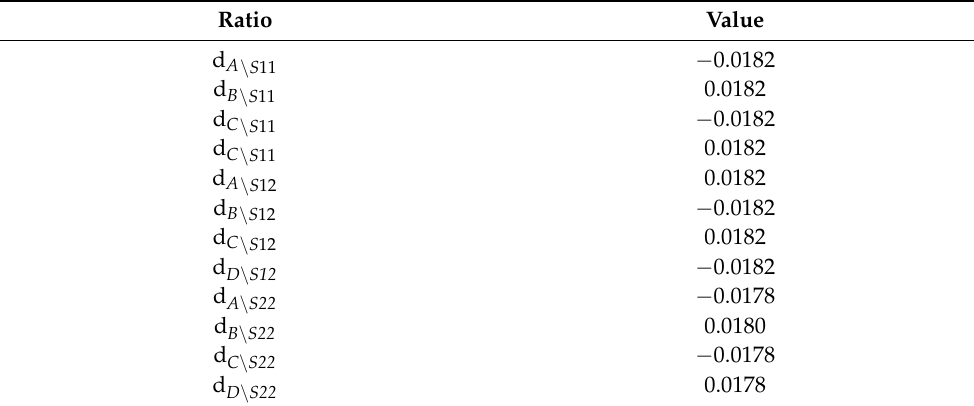
Table A7. The values of the division coefficients (for i, j = 1, 2) used to precisely define the folding of Ω ( B v ).